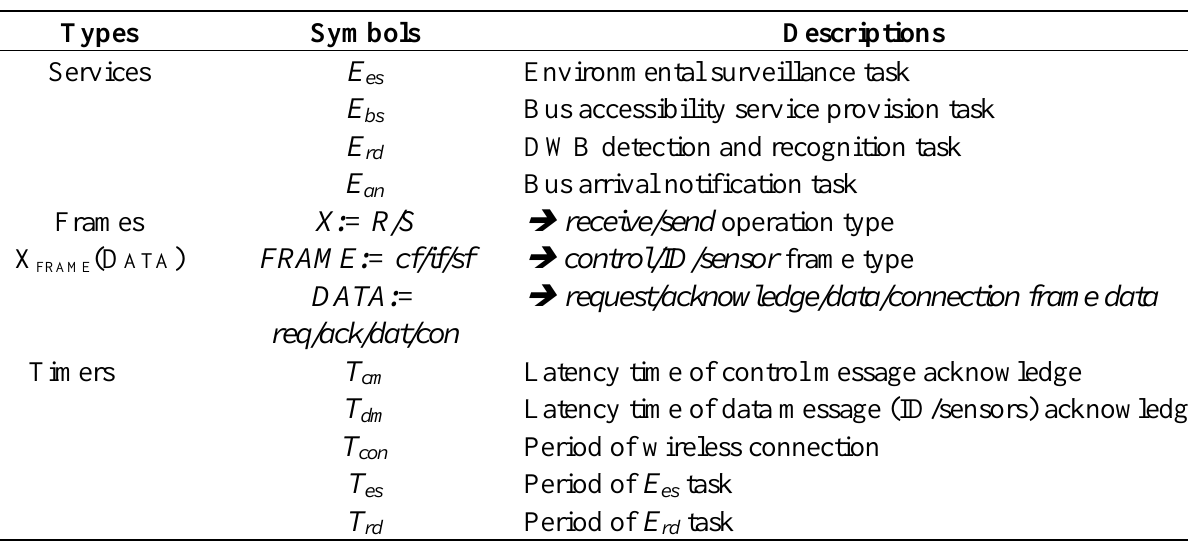
Table 1. Definitions of Mobi+